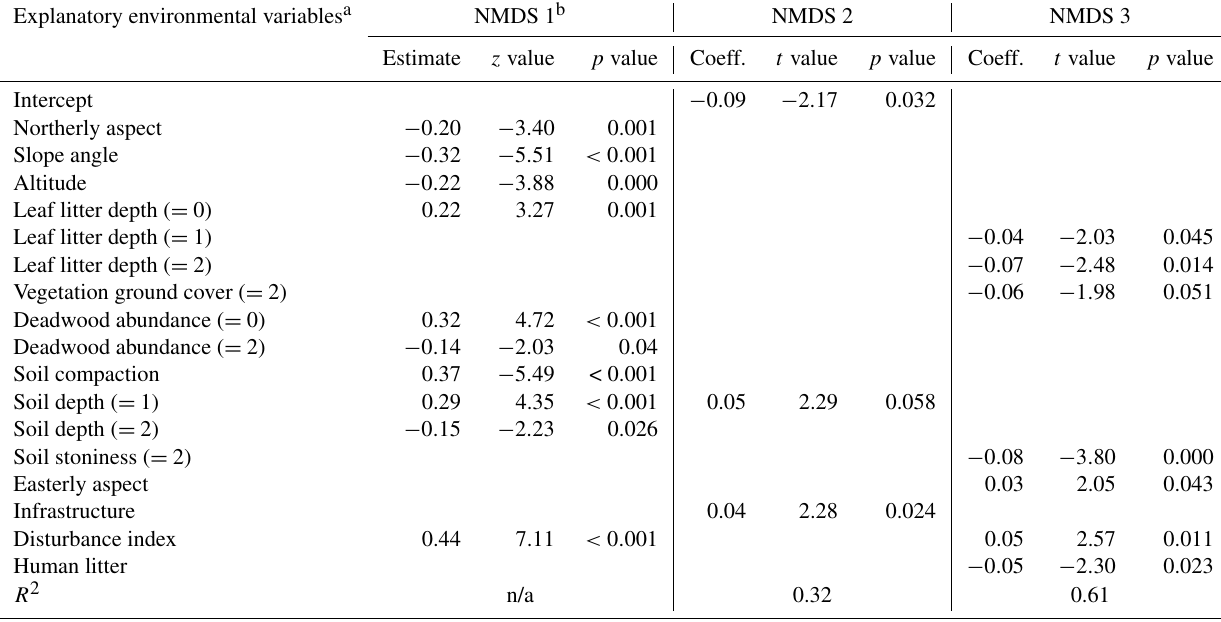
Table D1. Regression models between the three NMDS axis scores for understory saplings and shrubs (subplot layer) and plot environmental variables. Only variables significant at the p < 0 . 05 level are shown. The numbers in parentheses represent the different levels of the ordinal categorical variables. Coefficients are